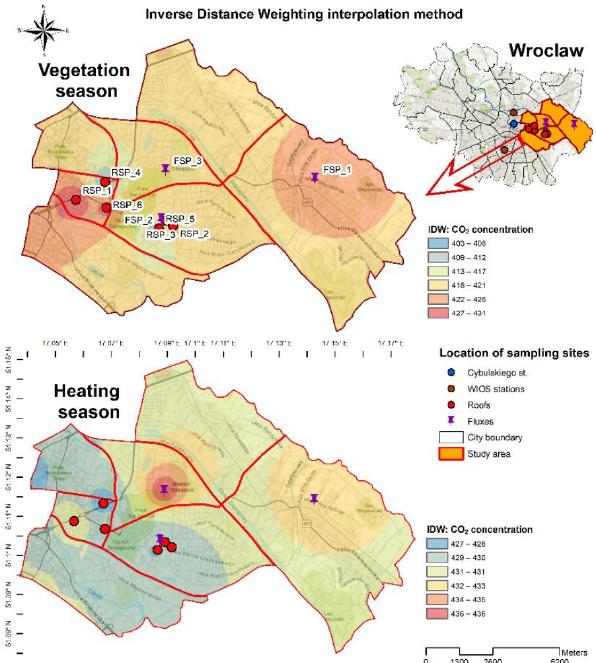
Figure 7. Geographic information system (GIS) coupling mapping of spatial CO 2 distribution in the vegetation and heating seasons, a surface produced using the IDW interpolation